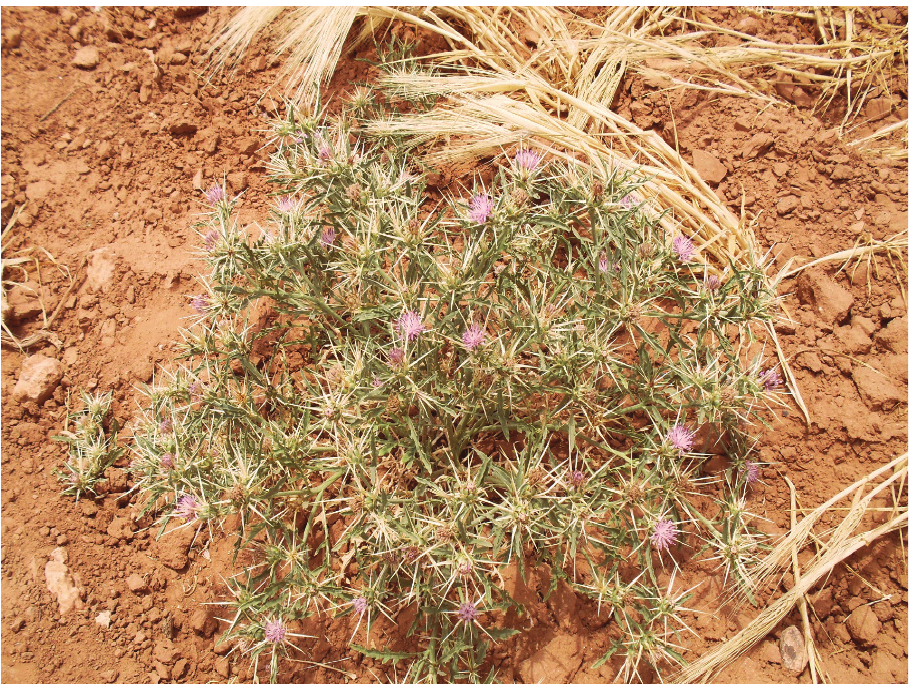
Figure 3. Centaurea calcitrapa L., host plant of Urophora mauritanica , Chaetorellia conjuncta and Terellia virens